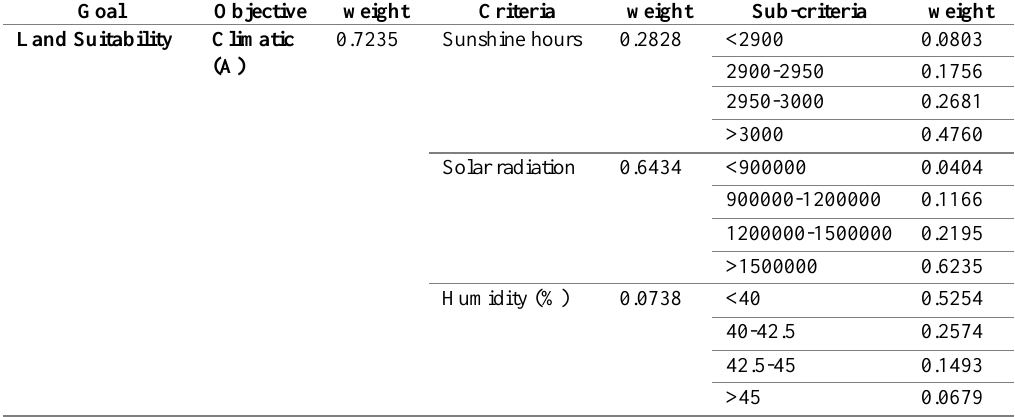
Table 2. Climatic objective for solar farm site